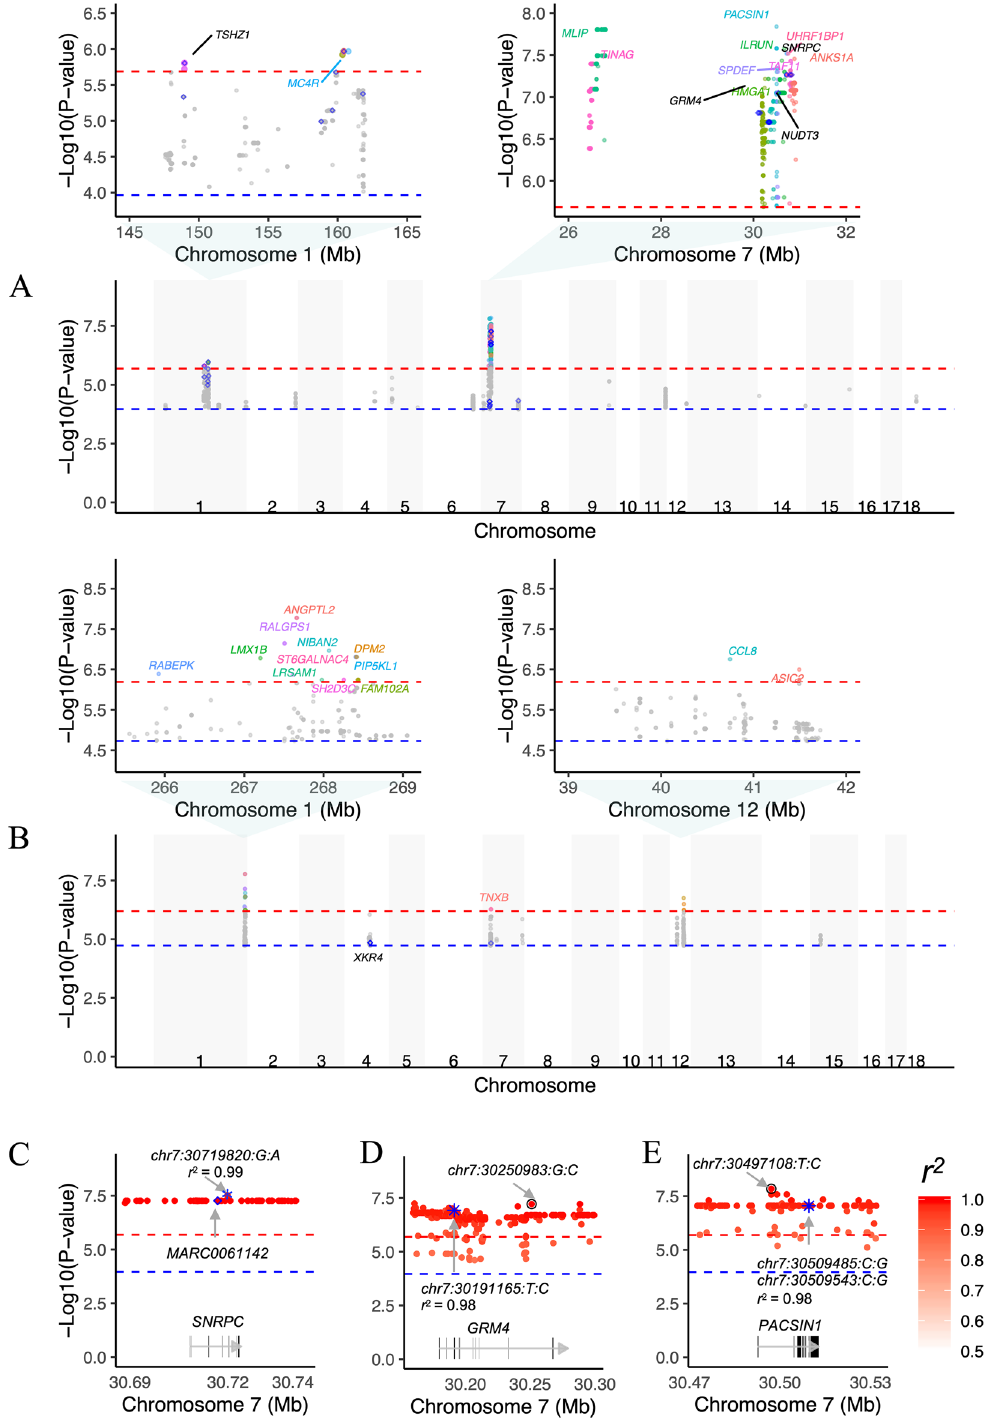
Figure 3. Association signals for growth phenotypes before and after imputation. Association test statistics on the − log10 ( P -value) scale (y-axis) are plotted for each SNP position (x-axis) for the trait of backfat thickness at an age of 180 days ( A ), from Zhang et al., and at 100 kg ( B ), from Fu et al. To simplify the plot, only the variants with a P -value less than 1.08 × 10 –4 are shown, and they are colored according to the annotated genes. The black-labeled genes are reported in the original paper, and the blue-labeled genes are novel genes detected after imputation. Examples of potential causal variants (marked by blue asterisks) in the SNRPC ( C ), GRM4 ( D ) and PACSIN1 ( E ) genes. Each dot represents a variant, whose LD ( r 2 ) with the Chip SNP (marked by blue diamonds) or the one with the lowest P -value (marked by a black circle) is indicated by the colour of the dot. The two horizontal lines divide SNPs with P -values < 2.05 × 10 –6 and < 1.08 × 10 –4 ( A ), and P -values < 6.46 × 10 –7 and < 1.86 × 10 –5 ( B